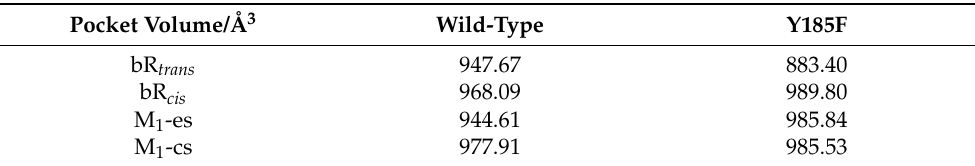
Figure 3. The conformational change in the retinal binding pocket and the interaction of Y185 with retinal in bR trans and bR cis . ( A , B ) Superimposed retinal binding pocket of WT-bR trans with Y185F-bR trans , and WT-bR cis with Y185F-bR cis . ( C , D ) Superimposed retinal binding pocket of WT-bR cis with Y185F-bR trans , and WT-bR trans with Y185F-bR cis . Color codings are the same as used in Figure 2E. ( E – H ) Dynamical cross-correlated map (DCCM) analyses of the C α atoms of WT-bR trans , WT-bR cis , Y185F-bR trans , and Y185F-bR cis by the simulations, respectively. Table 2. The retinal binding pocket volume of WT-bR cis , WT-bR trans , and M 1 states in the last frame trajectories.